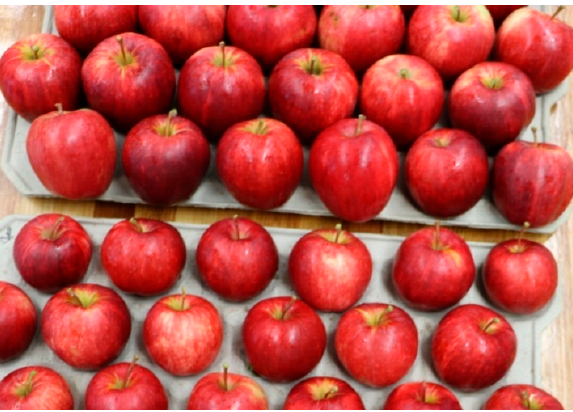
Figure 3. ‘Alvina Gala’ fruit from Trial 2. Upper tray shows fruit from trees managed through Artificial Bud Extinction (ABE) and lower tray shows fruit from the conventional regime with no chemical